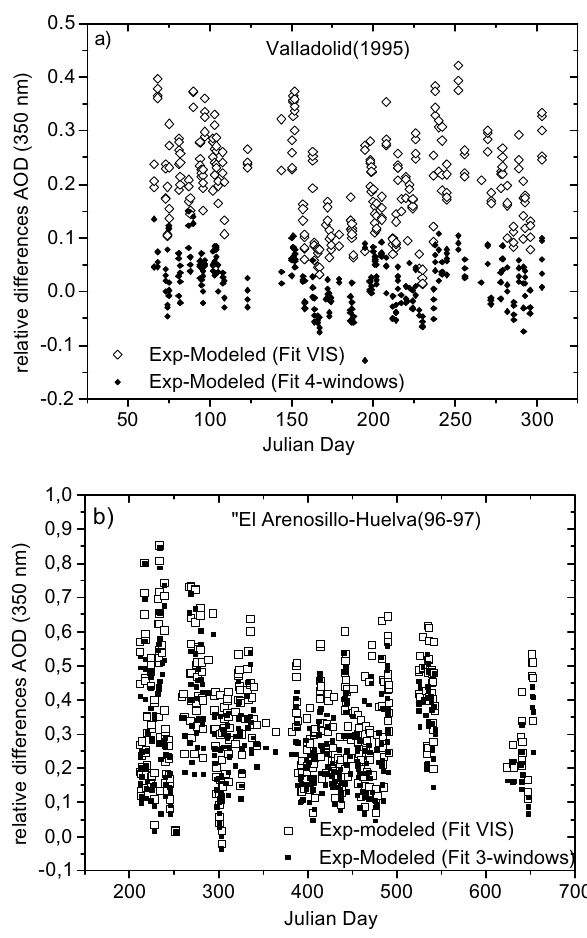
Fig. 2. Relative differences between the experimental AOD at 350nm and the AOD values retrieved from the values of the α − β parameters determined by the fits in the regions: a VIS (400–700) and b UV-VIS-NIR (“window